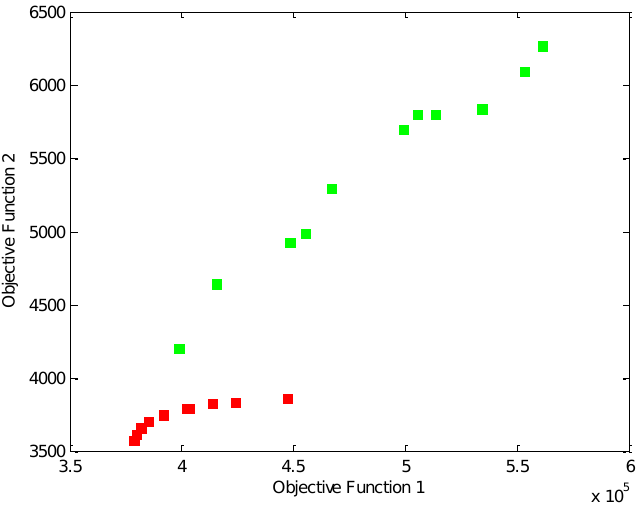
Figure 6. The normalized Pareto frontier associated with Scenario 2, and comparing this with the primary